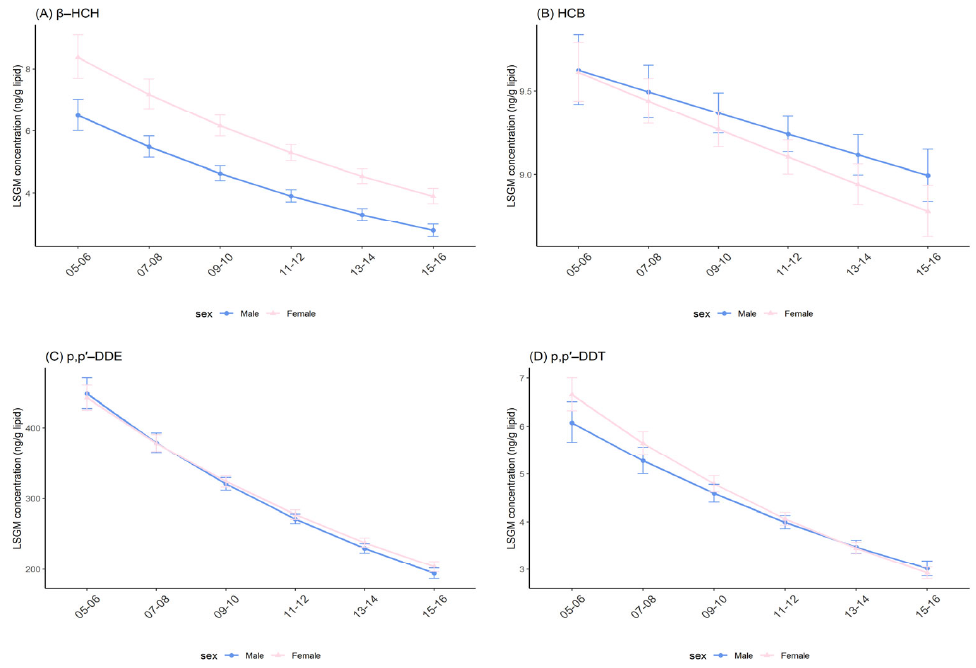
Figure 2. Temporal trends in serum OCP concentrations over survey cycles by sex. Least square geometric mean (LSGM) and 95% confidence interval (95% CI) for each survey cycle estimated from linear regression models adjusted for age group and race/ethnicity; interaction term is survey cycles##sex. Data points represent LSGM, and error bars represent 95% CI. ( A ): β‐ HCH. ( B ): HCB. ( C ): p,p ′‐ DDE. ( D ): p,p ′‐ DDT. Table 3. LSGM (ng/g Lipid) and 95% CI by Survey Cycles and Demographic Groups for β‐ HCH. Category LSGM 95% CI Pairwise Comparison: p